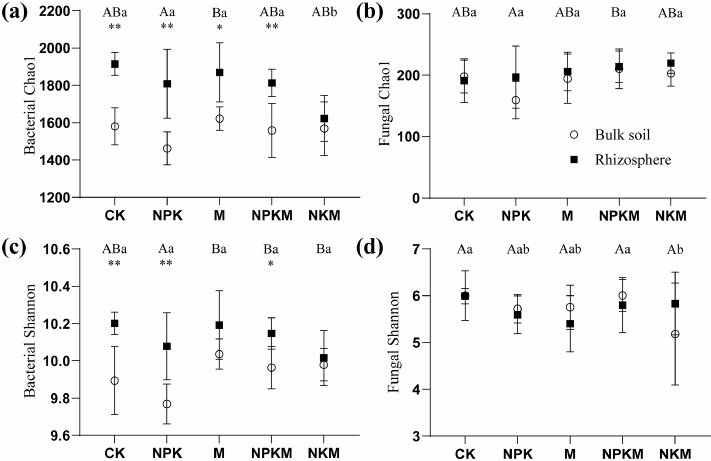
Figure 4. Mean ± SE values for microbial α diversity: (a) bacterial Chao1 index, (b) fungal Chao1 index, (c) bacterial Shannon index and (d) fungal Shannon index in five treatments (CK, NPK, M, NPKM, and NKM) and two sample types (rhizosphere and bulk soil). Significant differences between treatments in bulk soil are indicated by capital letters ( p < 0 . 05; n = 6). Significant differences between treatments in rhizosphere are indicated by lowercase letters ( p < 0 . 05, n = 6). Significant differences between rhizosphere and bulk soils are indicated by asterisks, where ∗ p < 0 . 05, ∗∗ p < 0 . 01 (Duncan’s test; n = 6).